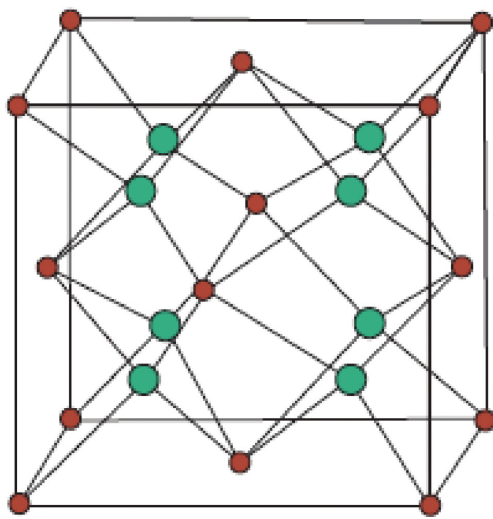
Figure 4: The graph of T